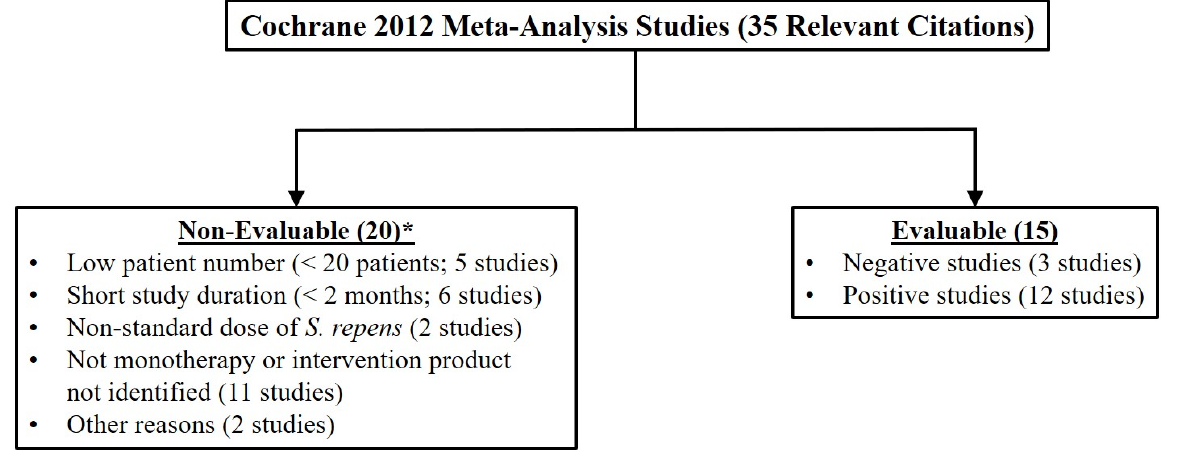
Figure 2. Cochrane 2012 patient evaluability. Of the 35 citations, only 15 were evaluable. Of those 15, only 3 were negative studies. * Some studies failed to meet evaluable criteria for more than one reason. Low patient numbers were identified in five studies, and a study duration of fewer than two months was found in six studies. Non-standard doses of Serenoa repens were noted in three studies, and nine studies did not involve monotherapy. In two studies, the intervention product and/or extraction technology could not be determined. Finally, one study had data that were not interpretable, and another article (Mohanty) did not specify the extraction technology.